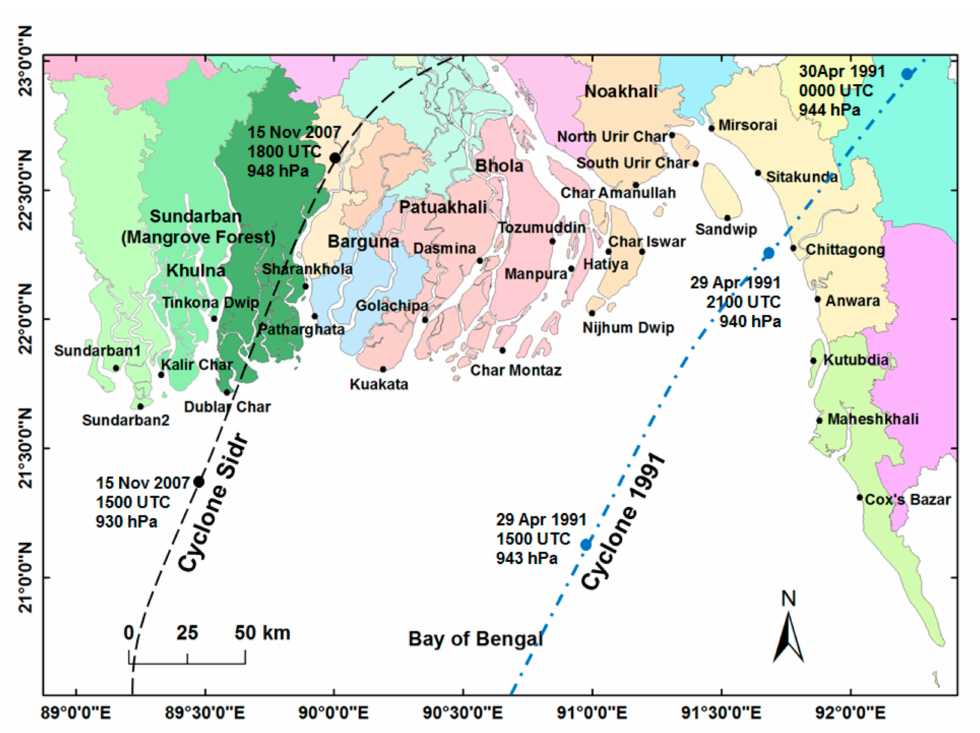
Figure 1. Tracks of Cyclone Sidr of 2007 and Cyclone 1991 along with the locations of interest in the Bangladesh